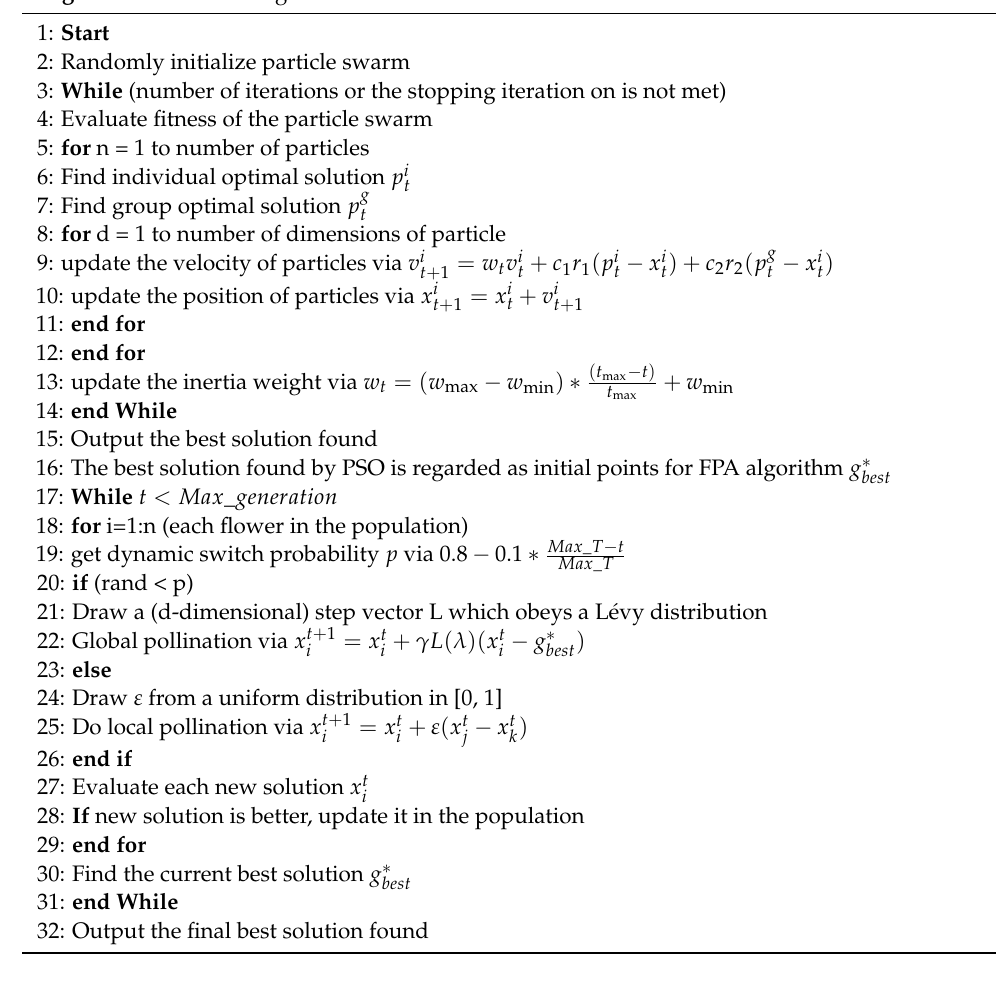
Algorithm 3. IFPASO